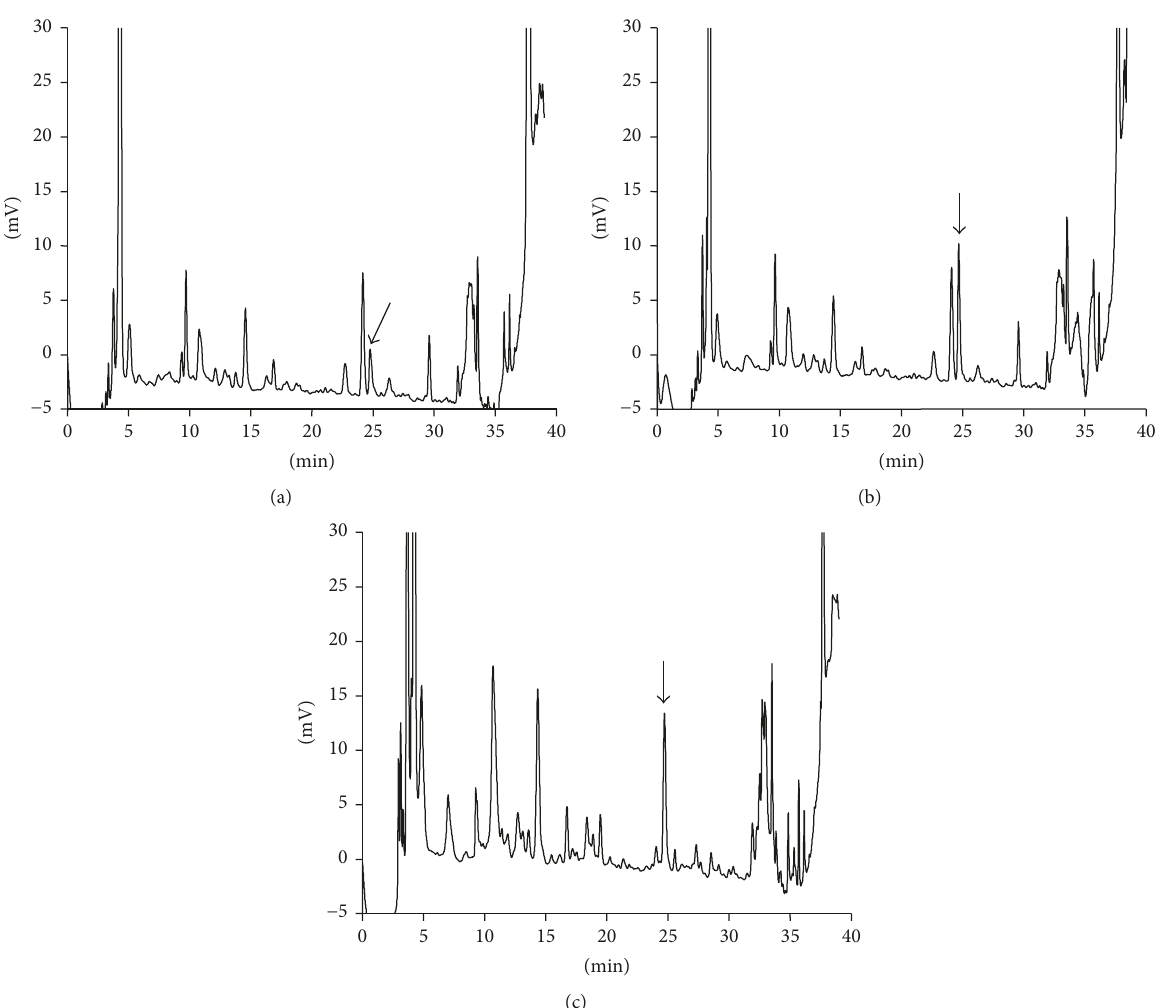
Figure 2: Chromatograms after deproteinization of a human urine blank (0.663 nM) (a), urine standard spiked with 1nM of pentosidine (b), and type 2 diabetes mellitus (T2DM) patient’s urine (2.28 nM) (c). The arrows show the pentosidine peak. The human urine used in (a) and (b) was obtained from a healthy male